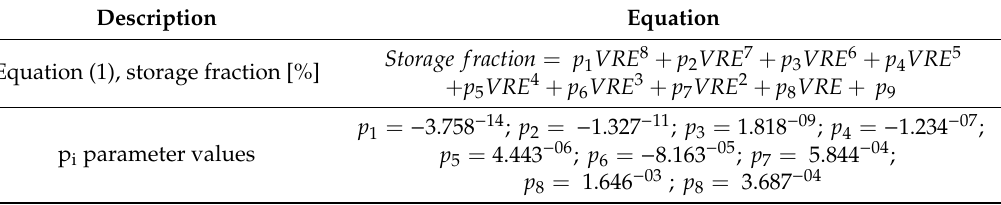
Figure 7. Result of the average European storage fraction analysis. Table 6. Result of the European storage fraction